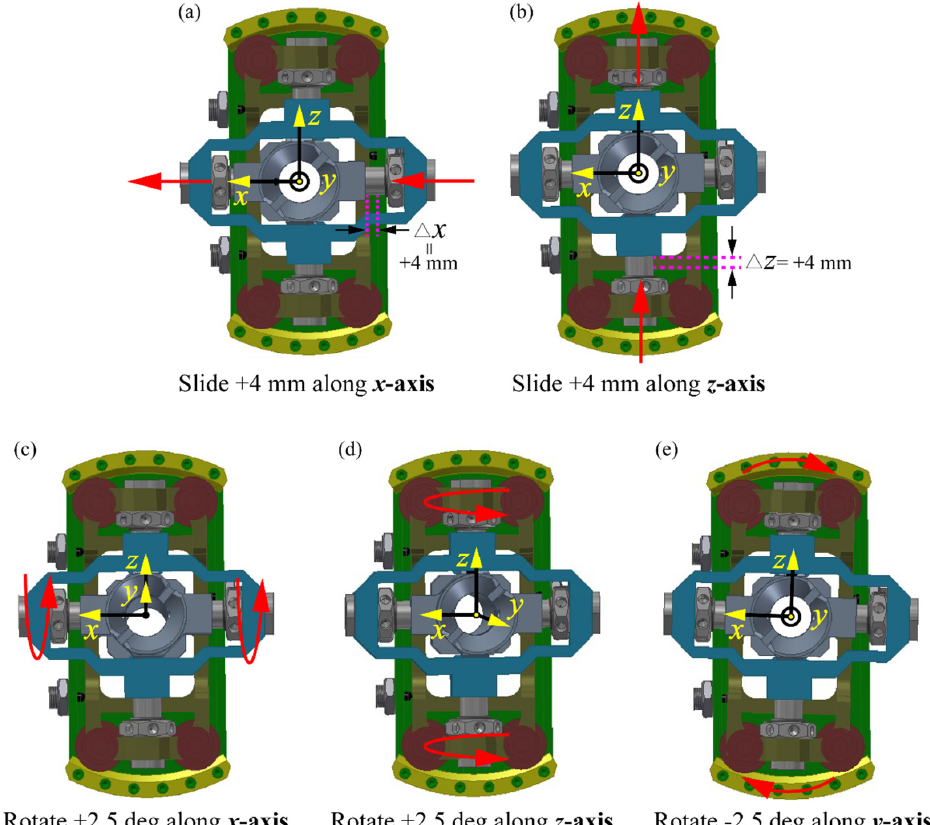
Figure 5. Principle of passive alignment subassembly: ( a ) slide along x -axis, ( b ) slide along z -axis, ( c ) rotate along x -axis (pitch), ( d ) rotate along z -axis (yaw), ( e ) rotate along y -axis (roll).